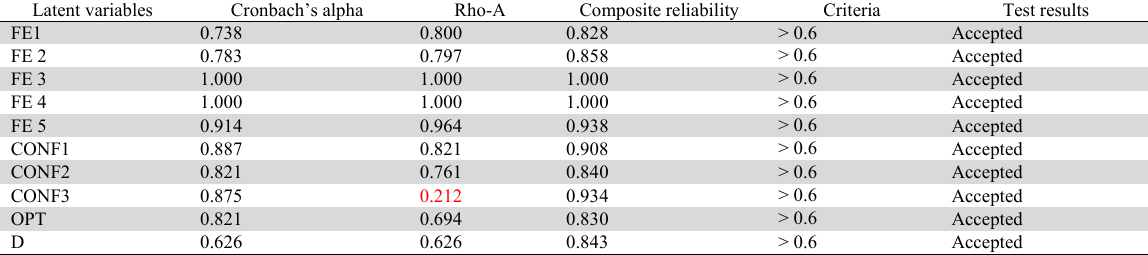
Summary of Statistical Tests: Cronbach’s Alpha and Composite Reliability (Model I) Latent variables